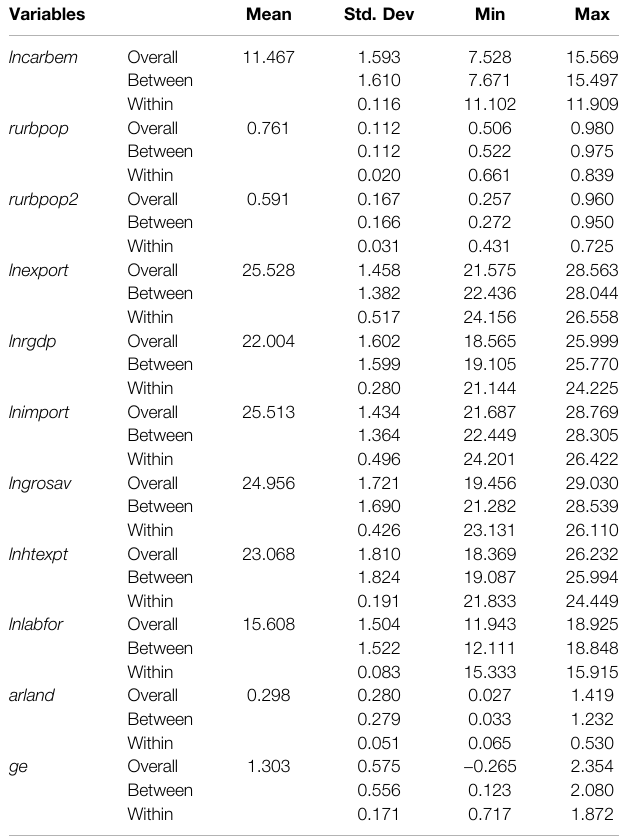
TABLE 1 | Statistical description of panel data.